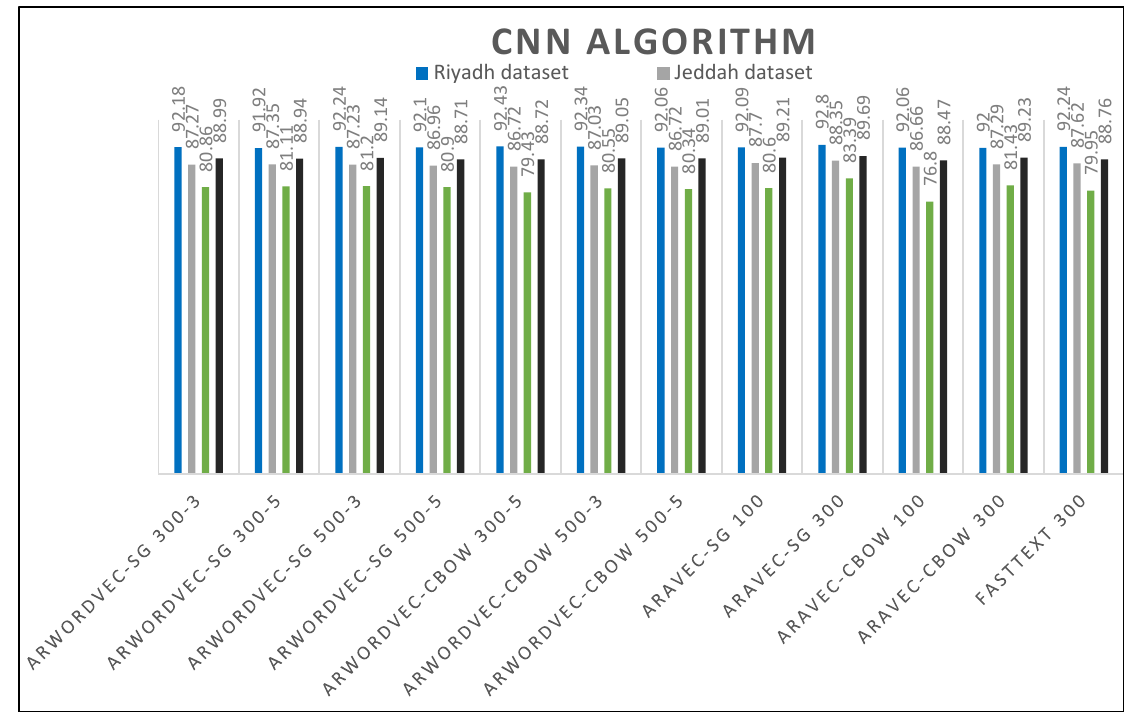
Figure 7. The Accuracies metric of CNN algorithm for comparing different Arabic pre-trained word embedding techniques for dataset before COVID-19.